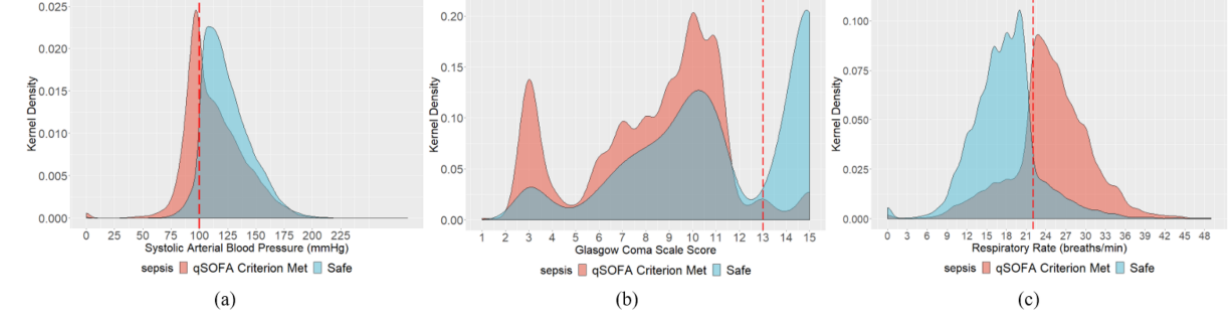
Figure 3. Kernel density estimation distribution of quick Sequential Organ Failure Assessment (qSOFA) parameters for both safe and qSOFA criterion-met observations to identify the prevalent qSOFA